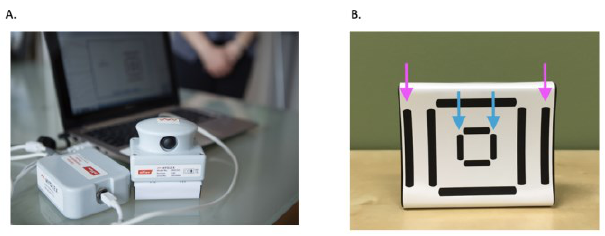
Figure 1. A. The Myolex mView TM system for neuromuscular assessment, including laptop, power convertor box, impedance measuring unit, and electrode array; B. Detail of electrode array used in this study; magenta-current emitting, blue-voltage sensing. Only data from these 4 electrodes were used in this